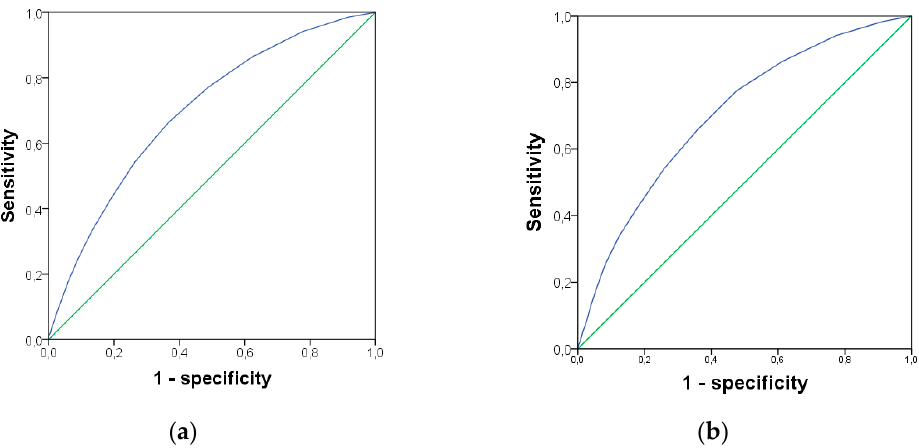
Figure 4. ROC curve that summarizes the potential of number of diseases to identify severe difficulty walking 500 m without assistance ( a ) and severe difficulty going up or down 12 stairs ( b ).